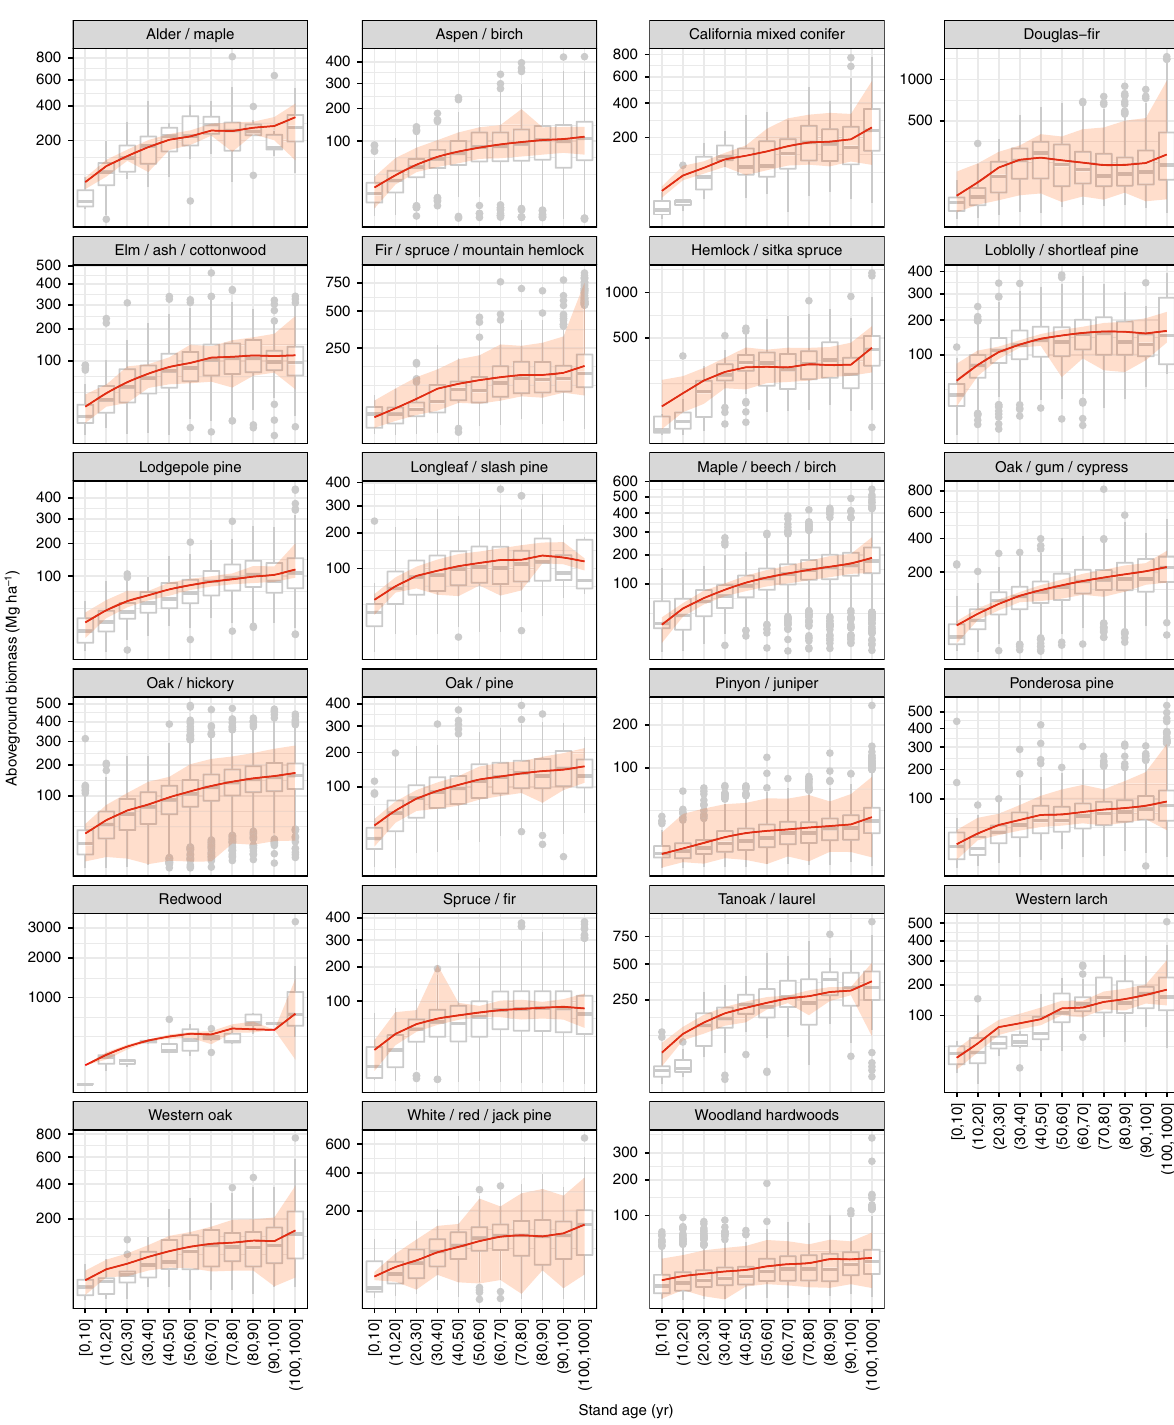
Fig. 1 Forest aboveground biomass current recovery with stand age across forest-type. Observed and modeled aboveground biomass and stand age in 23 primary forest types across North America are summarized for the current period, 2000 – 2016. Observed values (gray boxplots) are collected from the National Forest Inventory programs in the United States and Canada. Modeled values (red lines and ribbons) are calculated as the posterior means (lines) and 95% credible intervals (ribbons) from the hierarchical Bayesian growth model fi tted to the current data. Each forest-type is fi tted to the